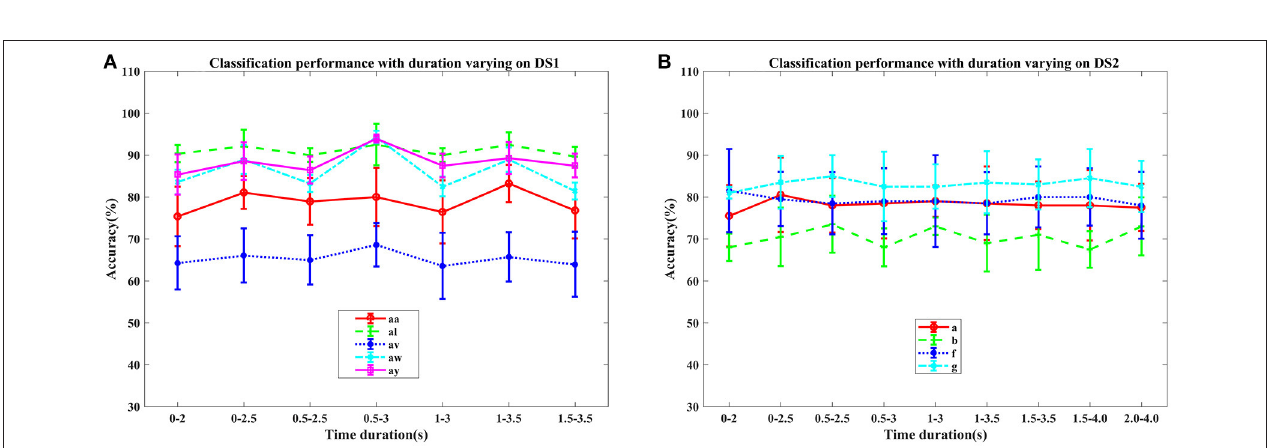
FIGURE 2 | Average classification accuracy (%) and standard deviation of COL with signal time duration varying on nine subjects: (A) aa, al, av, aw, and ay of DS1, and (B) a, b, f, and g of DS2. Each line type represents a subject’s mean and std. of classification accuracy at different time durations.